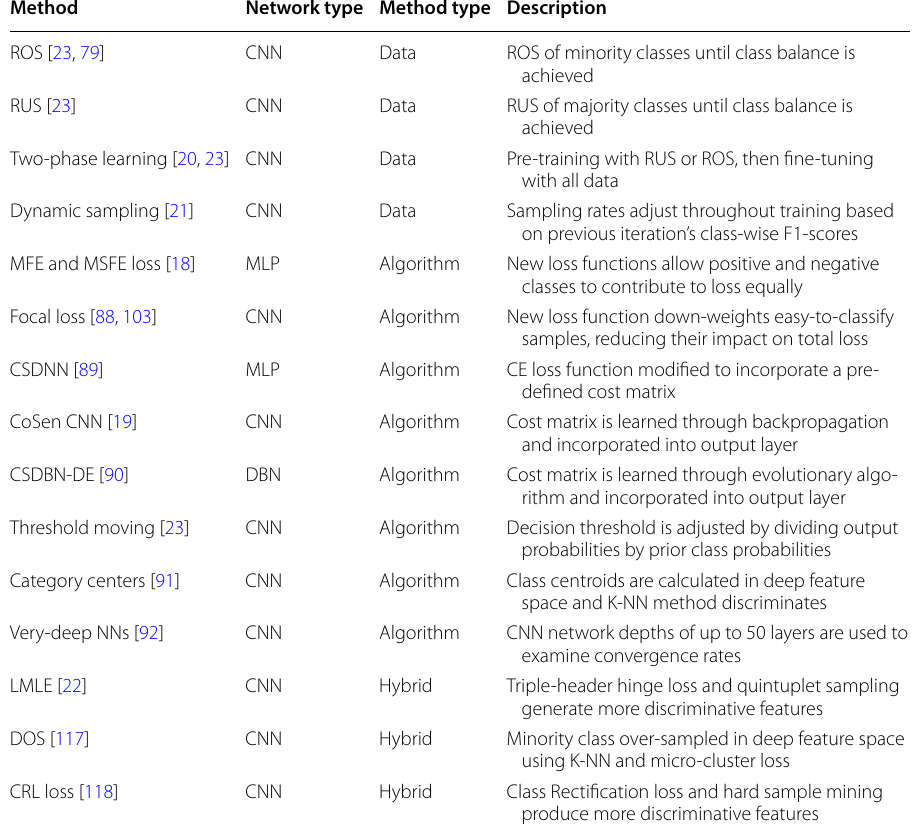
Table 17 Summary of deep learning class imbalance methods